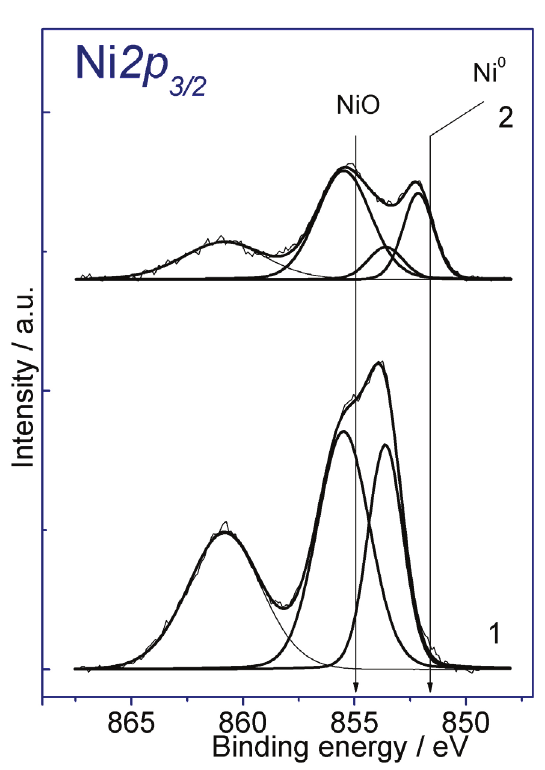
spectra for 5%Ni/ Ce 3/2 DR 4